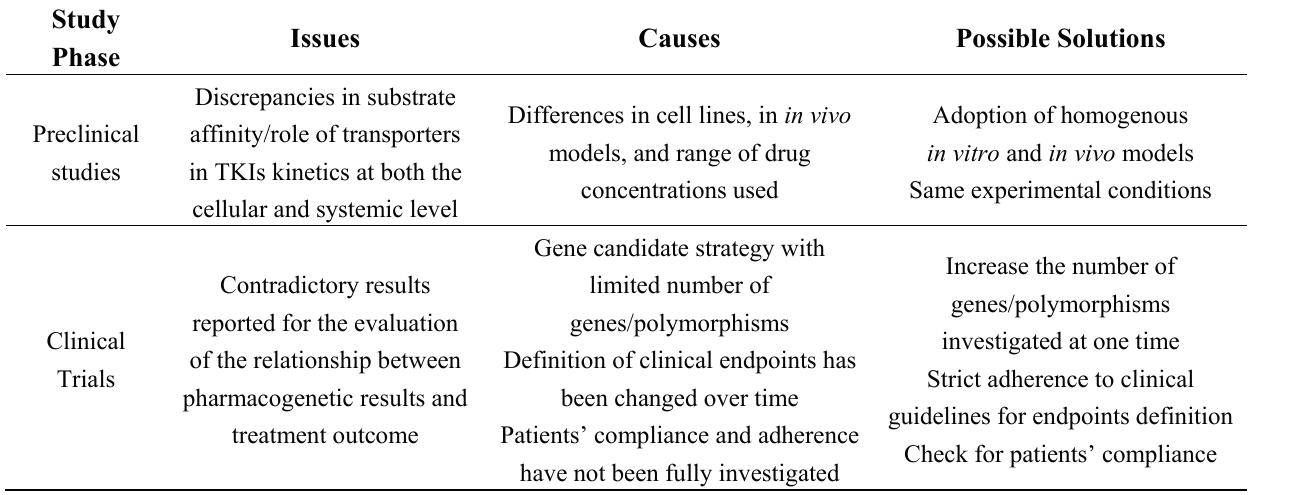
Table 3. Issues, causes and possible solutions related to contrasting results published in the literature regarding the search for TKI